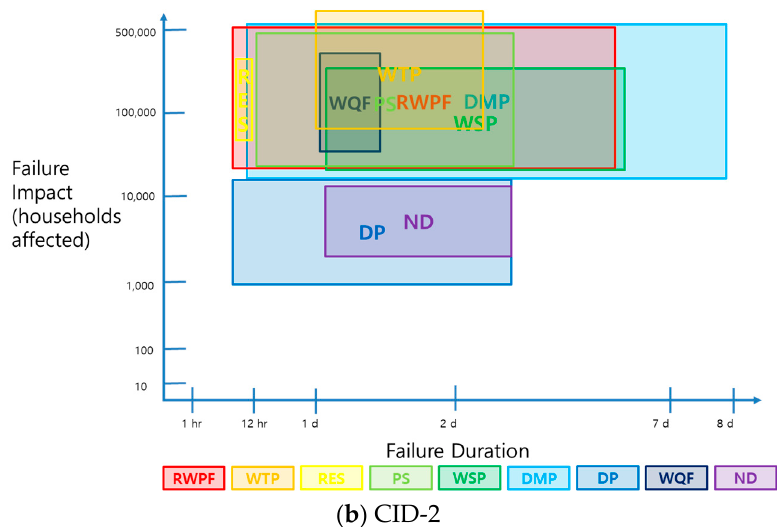
Figure 3. CID plots constructed from 331 component failure records bounded by ( a ) the minimum and maximum (CID-1 plot) and ( b ) the average and maximum (CID-2 plot) of the duration and impact of nine failures in Table 1.